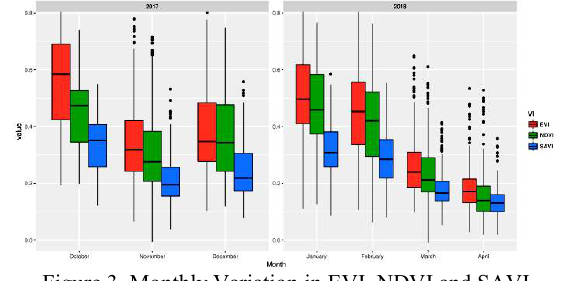
Figure 3. Monthly Variation in EVI, NDVI and SAVI